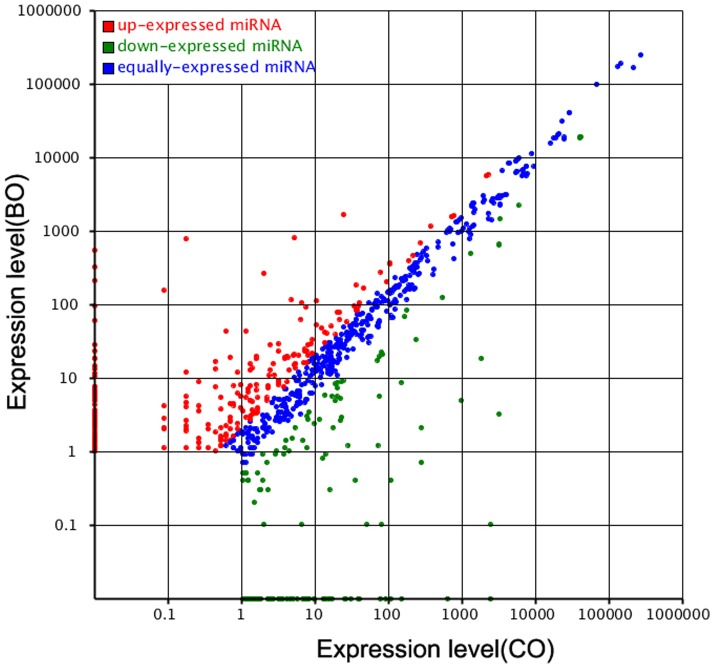
Differential expression of conversed miRNAs between LO and BO library.Each point in the figure represents a miRNA. Red points represent miRNAs with fold-change >2, blue points represent miRNAs with fold-change >1/2 and ≤2, green points represent miRNAs with fold-change ≤1/2.